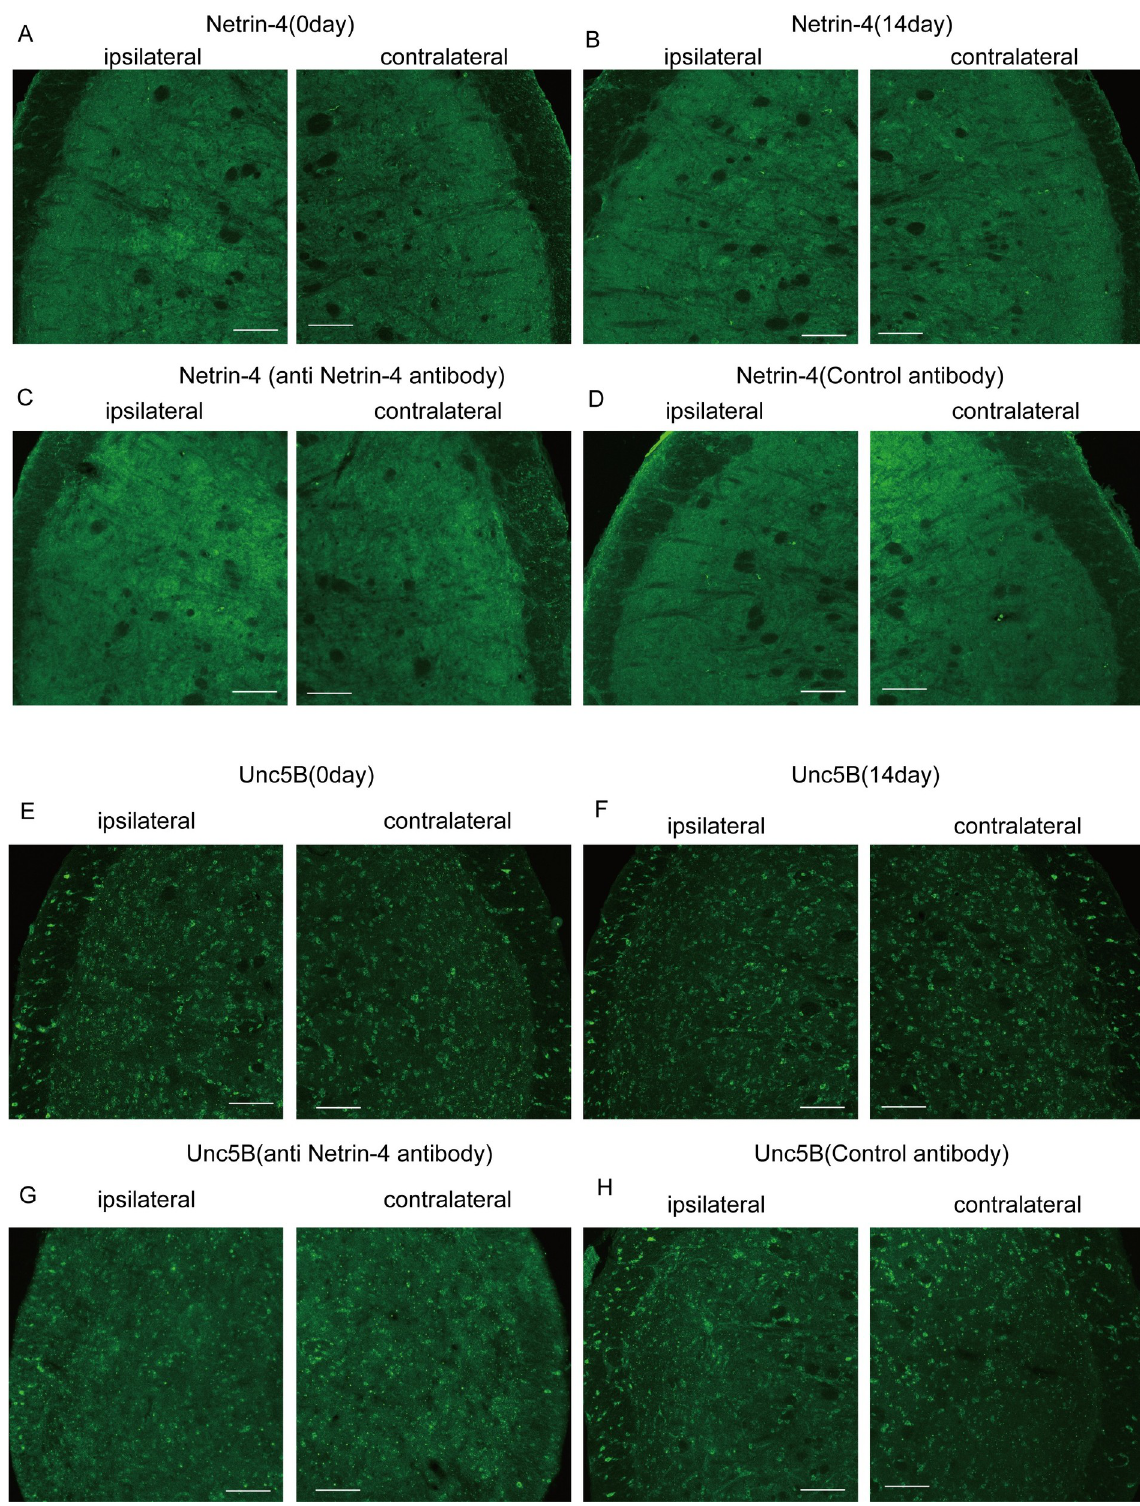
Fig 5. Expression of Netrin-4 and Unc5B receptor inVc-C1. (A and B) Netrin-4 expression in Vc of ipsilateral and contralateral side at 0 and 14days. (C and D) Netrin-4 expression in Vc of ipsilateral and contralateral side after anti-Netrin-4 antibody or Control antibody treatment. (E and F) Unc5B expression in Vc of ipsilateral and contralateral side at 0 and 14days. (G and H) Unc5B expression in Vc of ipsilateral and contralateral side after anti-Netrin-4 antibody or Control antibody treatment. Bars: 100 μ m. https://doi.org/10.1371/journal.pone.0251013.g005 PLOS ONE | https://doi.org/10.1371/journal.pone.0251013 April 29,